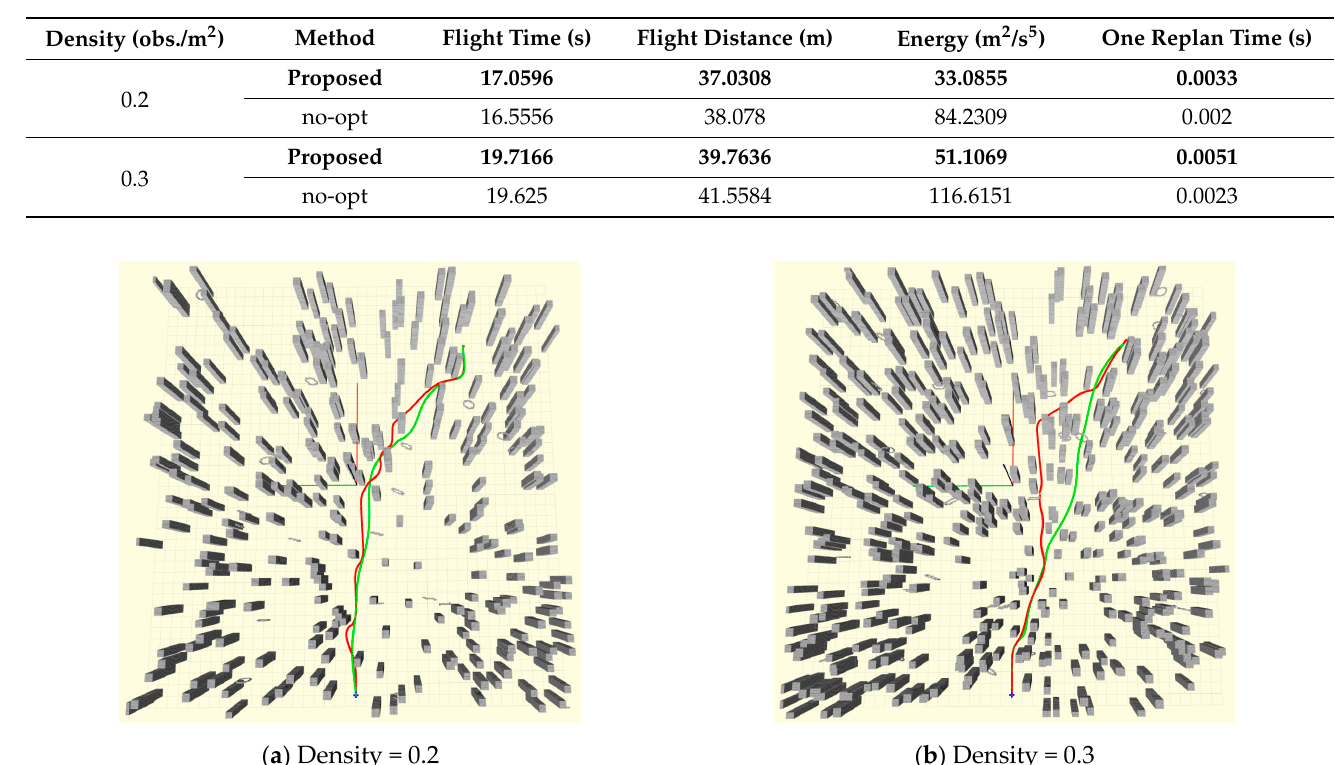
Table 3. The comparisons of the proposed method and no-opt.